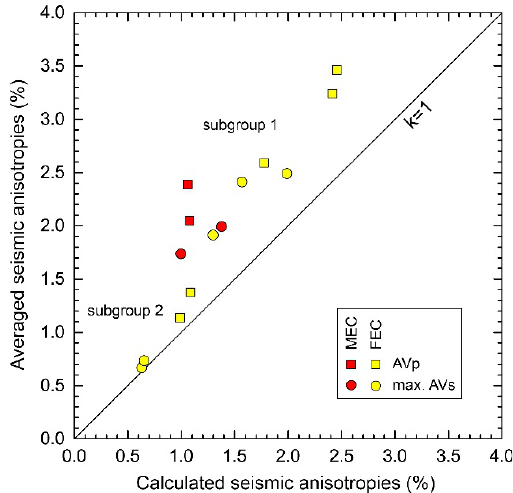
Figure 7. Comparisons of the bulk rock AVp and max. AVs between the directly calculated values (AVp cal and max. AVs cal ) and the indirectly averaged values (AVp avg and max. AVs avg ). The former were calculated conventionally using CPOs and volume proportions of all constituent minerals. The latter were estimated from the seismic anisotropies of all mono-mineralic polycrystals weighted by their volume proportions. The six and four yellow symbols in the upper and lower parts denote the FEC subgroups 1 and 2, respectively.